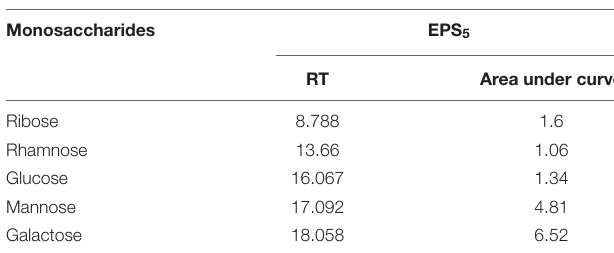
TABLE 4 | Determination of monosaccharide composition of L. delbrueckii ssp. bulgaricus DSM 20081 T -EPS 5 using